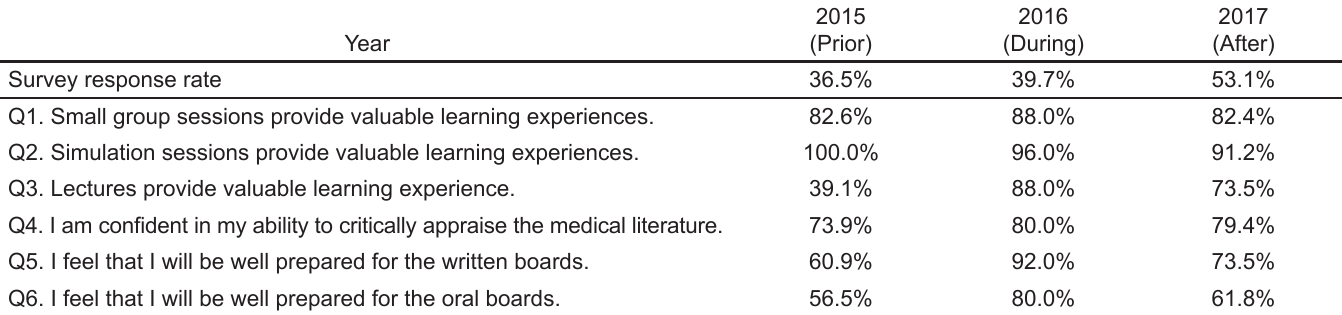
Table 1. Percentage of residents who responded “Agree” or “Strongly Agree” by